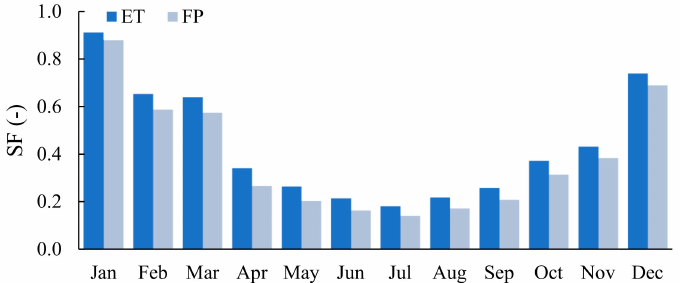
Figure 8. System monthly solar fractions for FP and ET collectors. ET = evacuated tube. FP = flat